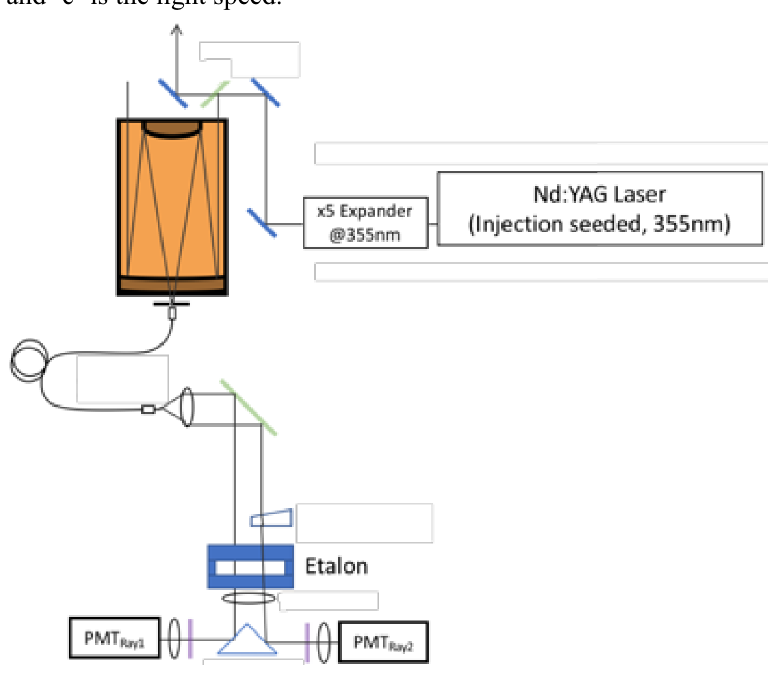
Figure 1. Block diagram of 355-nm direct-detection Doppler wind